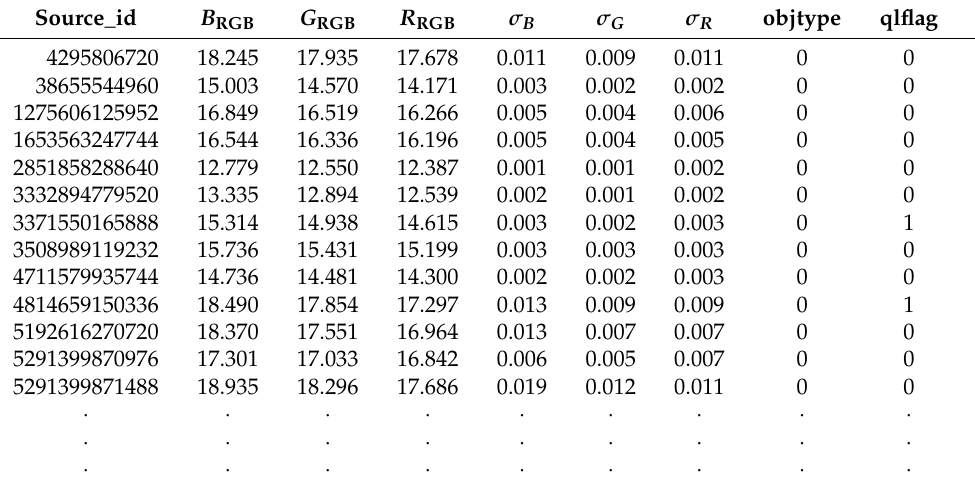
Table 2. First rows of the online table with the synthetic RGB magnitudes ( B RGB , G RGB and R RGB ) and their associated uncertainties ( σ B , σ G and σ R ) derived for the 200 M sample from the Gaia DR3 XP spectra for non-variable sources in the Gaia catalogue with id number equal to source_id. The column objtype is a flag that indicates the type of object in Gaia DR3: 1 for sources flagged as non_- single_star , 2 for objects in in_qso_candidates , 3 for sources in in_galaxy_candidates and 0 for the rest of the sample. In addition, the last column, qlflag, provides a global quality flag, which is 0 for reliable sources and 1 for objects with any indication of potential problem (blending, contamination or non-stellar identification). The full table can be downloaded from the link provided in the text, and will also be available at the